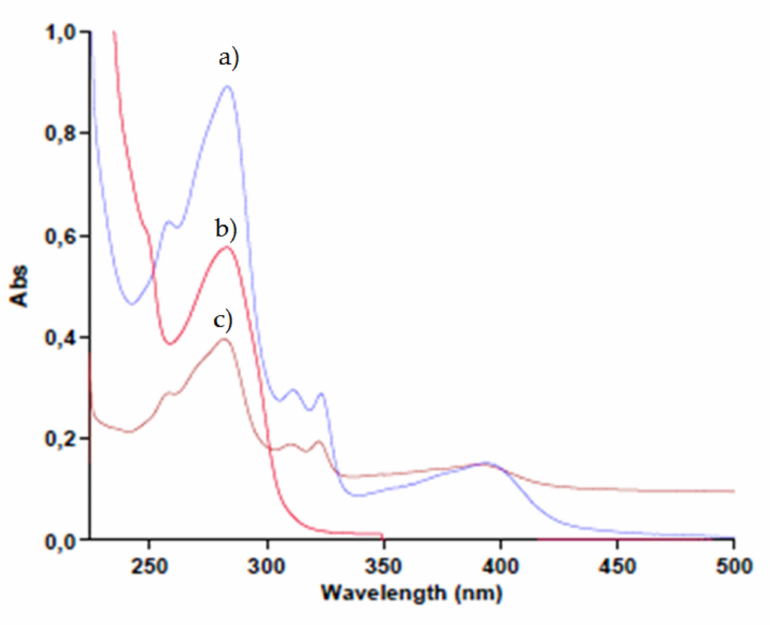
Figure 4. UV–Vis spectra of ( a ) Pt(Bipy)Cl 2 , ( b ) PLLA-Bipy and ( c ) Pt(PLLA-Bipy)Cl 2 collected in CH 2 Cl 2 solution (M = 0.005 mol /